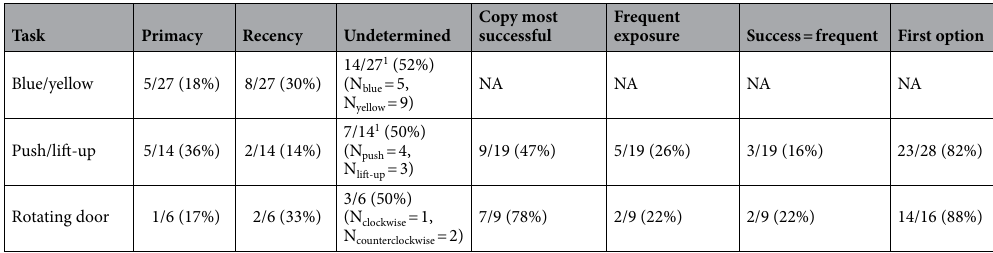
Table 5. Proportion of individuals of a group of Barbary macaques ( Macaca sylvanus ) at Trentham Monkey Forest (UK) that show individual option-preference effects. Primacy and recency effects were based on individuals that observed both options being solved prior to first successful interaction. Other effects include all potential social learners (except first option, which also includes asocial learners). Undetermined: first and most recent successful option seen were the same. 1 Five preferred the opposite to the preferred option observed. Successful = frequent: preferred option of most frequently, and most successful, individual observed are the same.